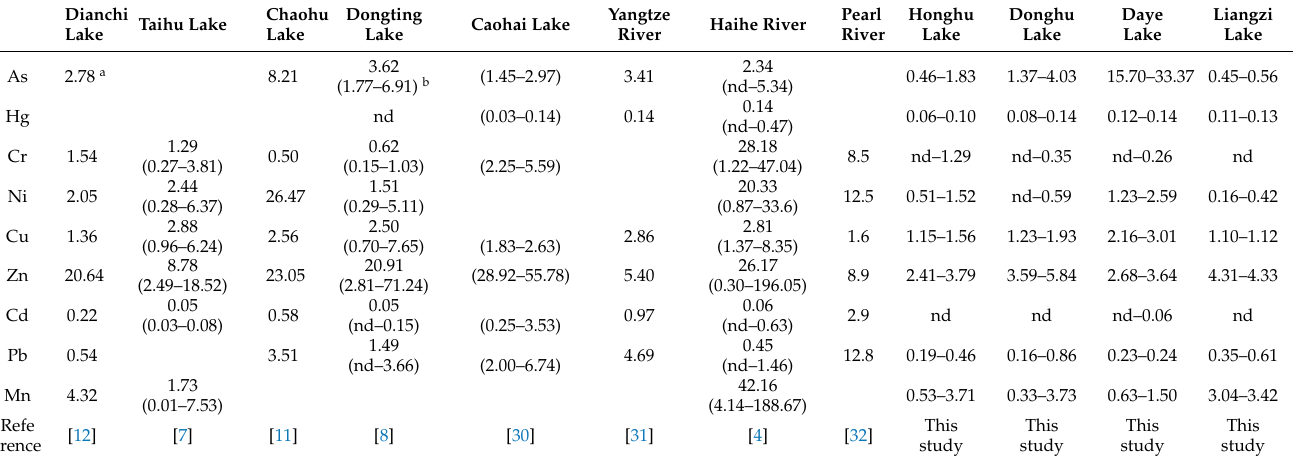
Figure 2. Heavy metals in the water columns: ( a ) concentration of heavy metals in surface water and bottom water; ( b ) distribution of heavy metals in surface water and bottom water; and ( c ) distribution of heavy metals in the water columns of different lakes. Oval represents 95% confidence interval. Table 2. Comparison of heavy metals in Honghu Lake, Daye Lake, Liangzi Lake, and East Lake with other surface waters in China ( µ